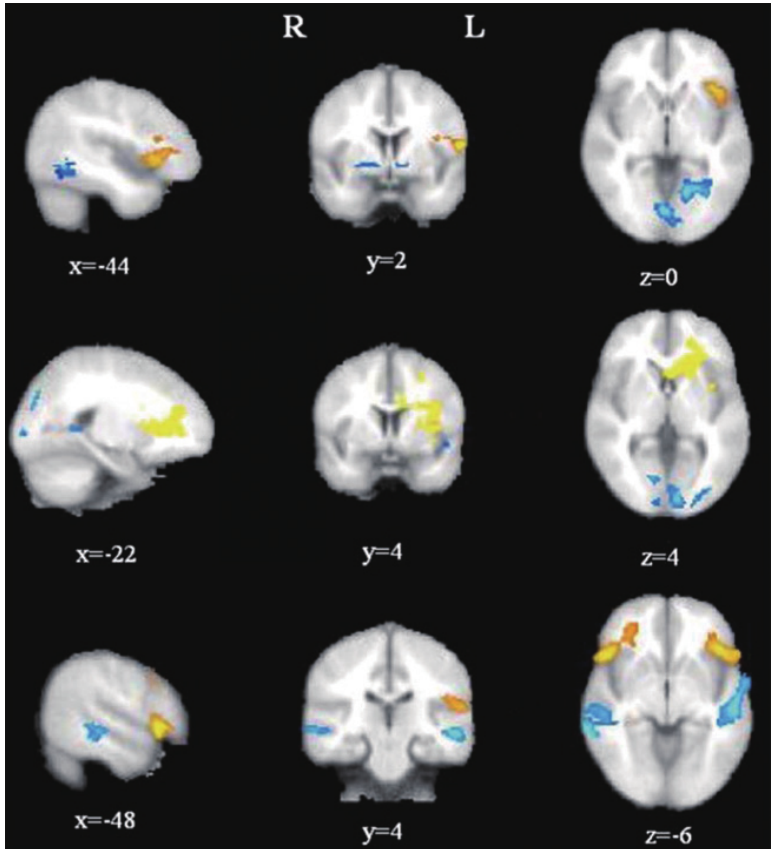
Fig. 3. Age-related activations visual (top), verbal (middle) and auditory (bottom) working memory tasks. Hot colors point to positive (older > younger) activations and cold colors negative activations (younger > older) for each contrast. Sagittal sections show left hemisphere. All maps are thresholded at a whole-brain corrected P < 0.05 using cluster-wise P < 0.05. For details see Table